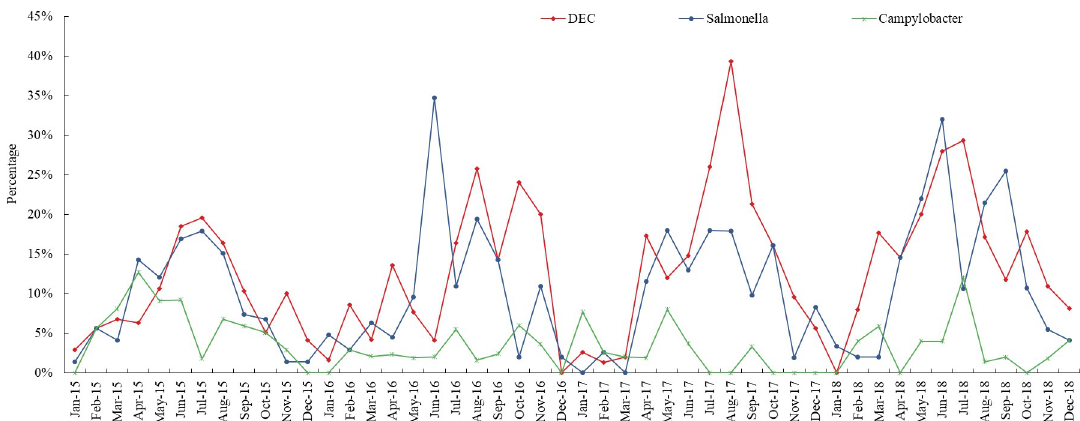
Fig 2. Seasonal prevalence of bacteria in children with acute diarrhoea in